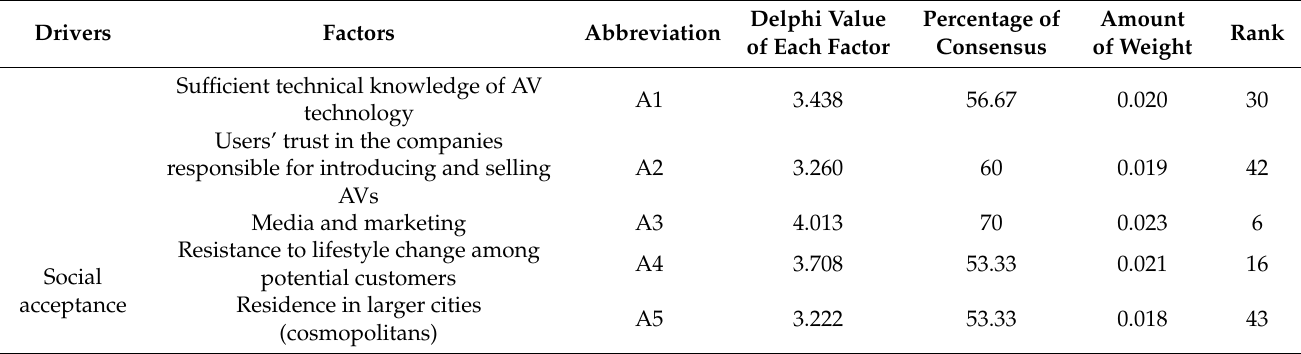
Table 3. Factors affecting the development of AVs, fuzzy Delphi results.